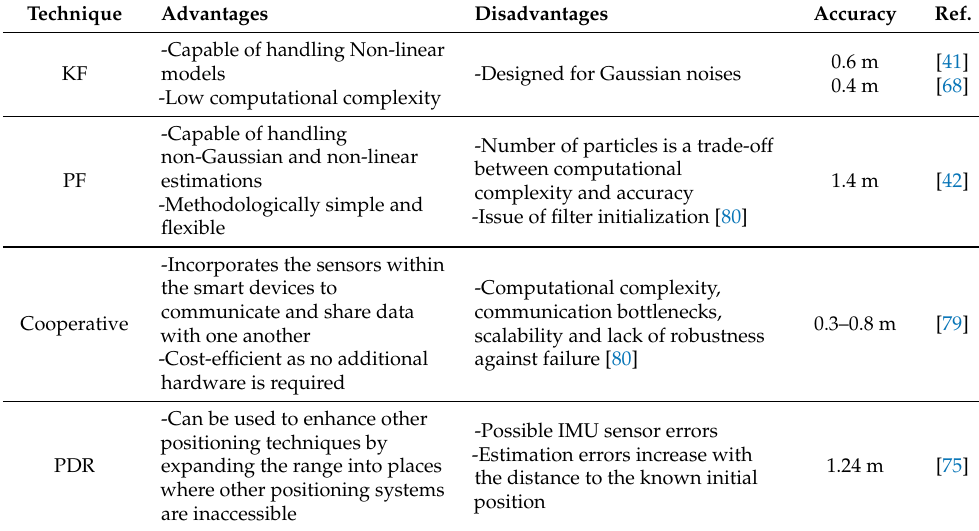
Table 4. Sensor Fusion 3D Positioning Existing